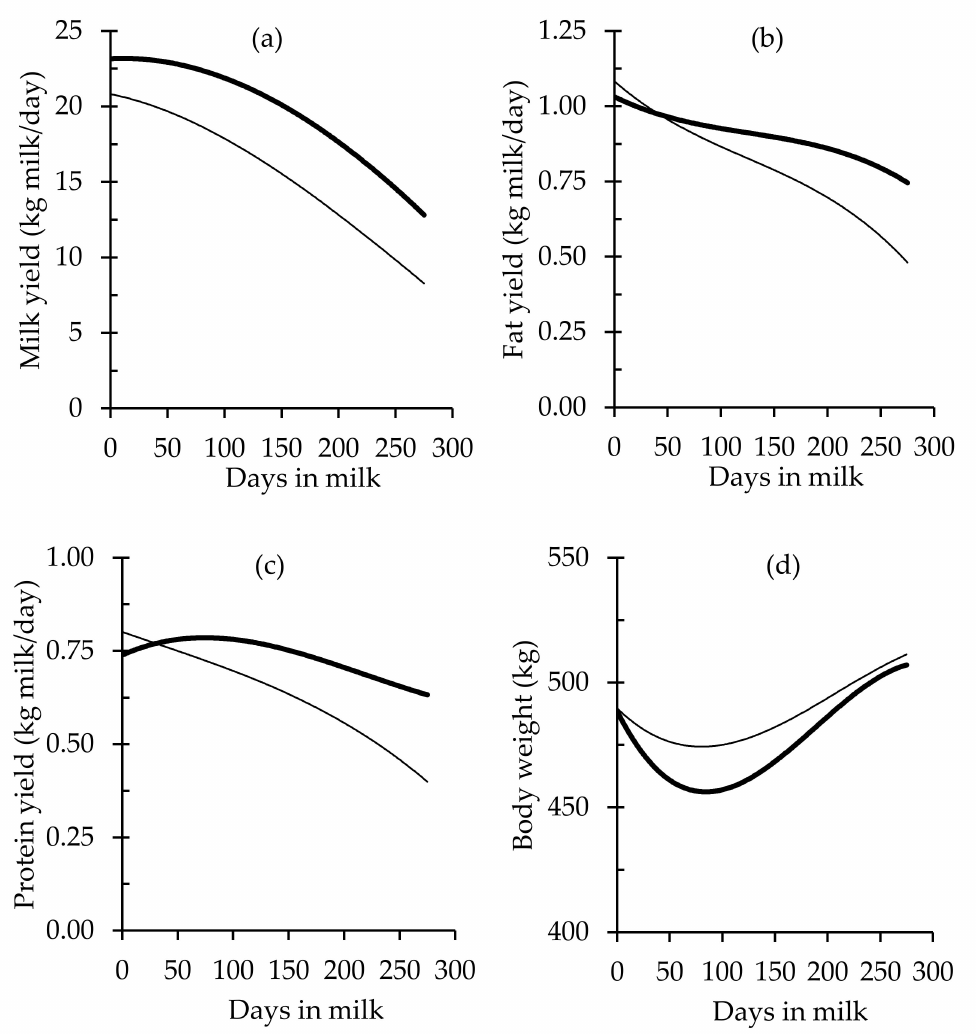
Figure 1. Predicted lactation curves of yields of ( a ) milk, ( b ) fat, and ( c ) protein, and ( d ) body weight of grazing cows throughout a full lactation in two contrasting pasture-based dairy production systems: a low-intensity production system (—) and a high-intensity production system ( — ). Estimates of mean N excreta during the lactation (g N per day) was higher in the LIPS cows when compared to the HIPS cows ( p < 0.001; Figure 3), with a higher proportion of UN ( p < 0.001; Figure 3b). Mean FN per day was higher in HIPS ( p = 0.0018; Figure 3c). Cows in HIPS had significantly higher DMI, with a higher proportion of nonpasture supplements of lower CP (compared to fresh grazed pasture) included throughout the lactation, which led to a diet lower in CP (Figure